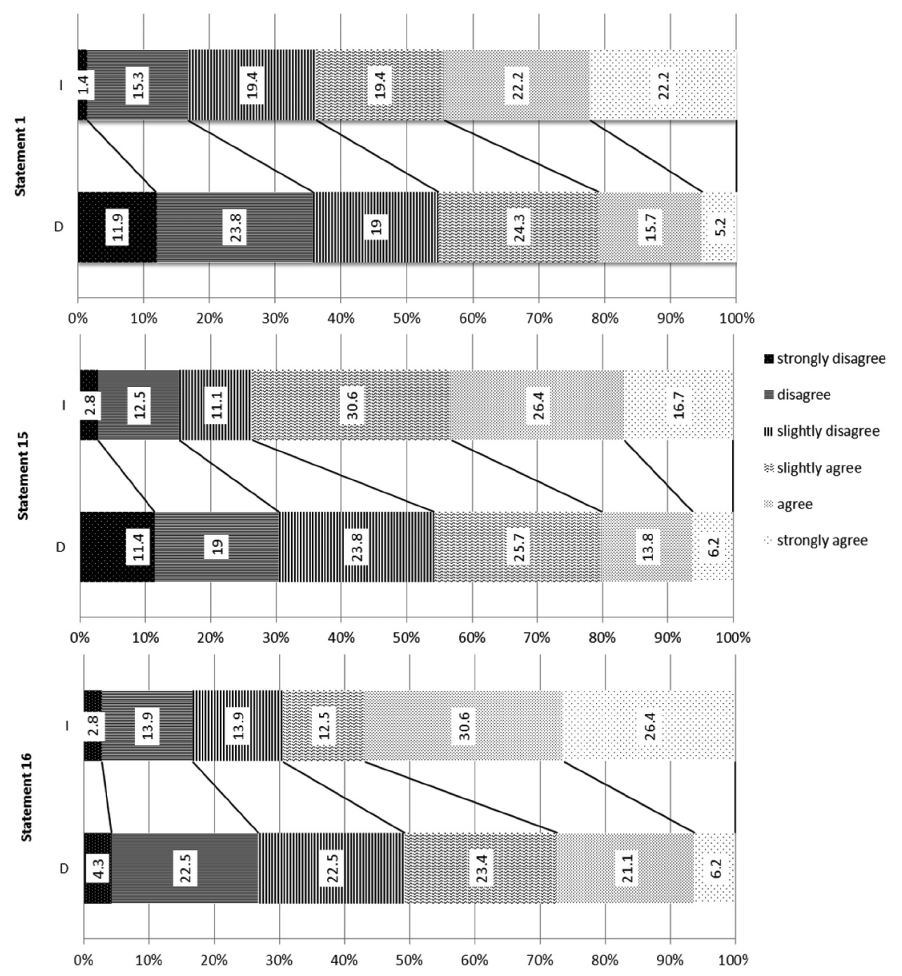
Figure 2: Answers for three statements of students from regular (D) and international (I) schools in the Netherlands, in